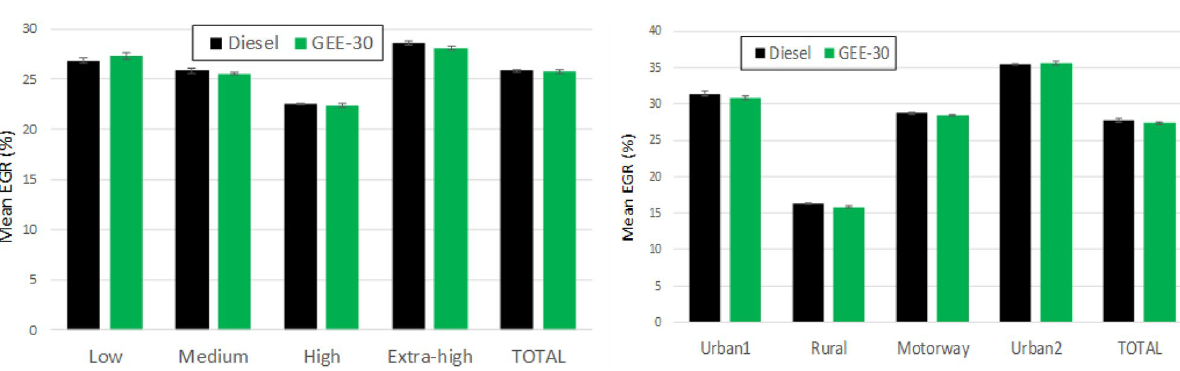
Figure 6. Mean EGR rate for the different phases of WLTC (left) and RDE